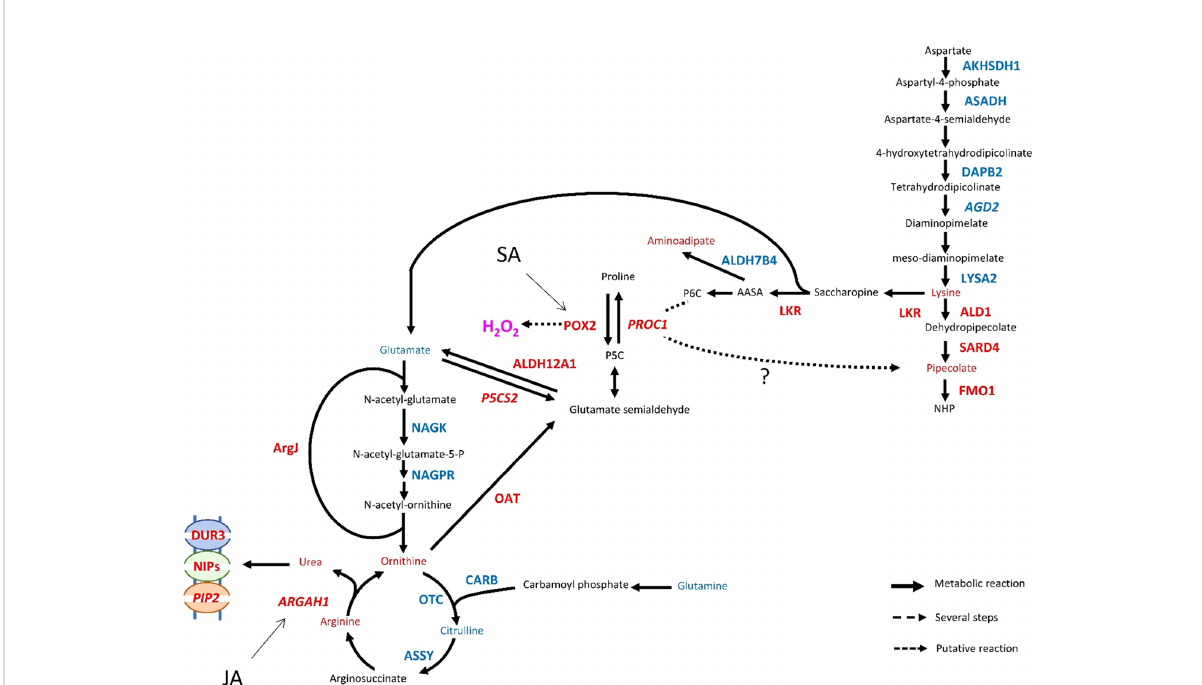
FIGURE 8 Transcriptional regulation of Arginine, proline and lysine metabolic pathways in Rubira 48 hours after infestation with GPA. Genes are annotated according to their Arabidopsis orthologs, non-orthologs (homologs) are noted in italics. Upregulated genes/metabolites are fi gured in red, downregulated genes/metabolites in blue and not found or not differentially expressed genes/metabolites in black. AGD2, LL-diaminopimelate aminotransferase; AKHSDH1, Aspartokinase/homoserine dehydrogenase 1; ALD1, AGD2-like defense response protein 1; ALDH12A1, Delta-1- pyrroline-5-carboxylate dehydrogenase 12A1; ALDH7B4, Aldehyde dehydrogenase family 7 member B4; ARGAH1, Arginase 1; ArgJ, Arginine biosynthesis bifunctional protein; Aspartate-semialdehyde dehydrogenase; ASSY, Arginosuccinate synthase; CARB, Carbamoyl-phosphate synthase large chain; DAPB2, 4-hydroxy-tetrahydrodipicolinate reductase 2; DUR3, Urea-proton symporter; FMO1, Probable fl avin-containing monooxygenase 1; LKR/SDH, Alpha-aminoadipic semialdehyde synthase; LYSA2, Diaminopimelate decarboxylase 2; NAGK, Acetylglutamate kinase; NAGPR, N-acetyl-gamma-glutamyl-phosphate reductase; NIP1, Aquaporin Nodulin-26-like major intrinsic protein; OCT, Ornithine carbamoyltransferase; P5CS2, Delta-1-pyrroline-5-carboxylate synthase; PIP2, Aquaporin Plasma membrane intrinsic protein; POX2, Proline dehydrogenase 2; PROC1, Pyrroline-5-carboxylate reductase; SARD4, SAR de fi cient 4; AASA, alpha-amino adipate; NHP, N-hydroxypipecolate; P5C, Pyrroline-5-carboxylate; P6c,